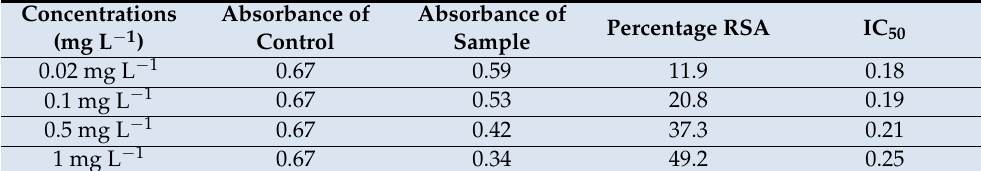
Table 1. Percentage (%) scavenging and IC 50 of standard (ascorbic acid).